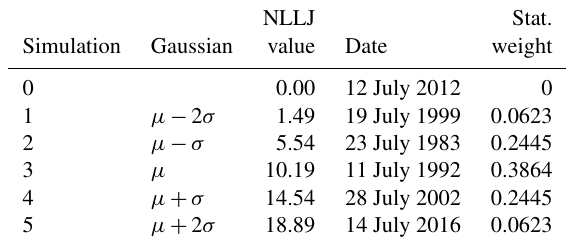
Table 1. Case studies objectively selected based on the frequency distribution of the NLLJ index to carry out WRF-WVT simulations. µ is the mean of the distribution and σ its standard deviation. Note: the frequency distribution is calculated at the point of maximum intensity of the NLLJ at 32.75 ◦ N, 99 ◦ W (black cross in Fig. 1a) using the ERA-Interim reanalysis